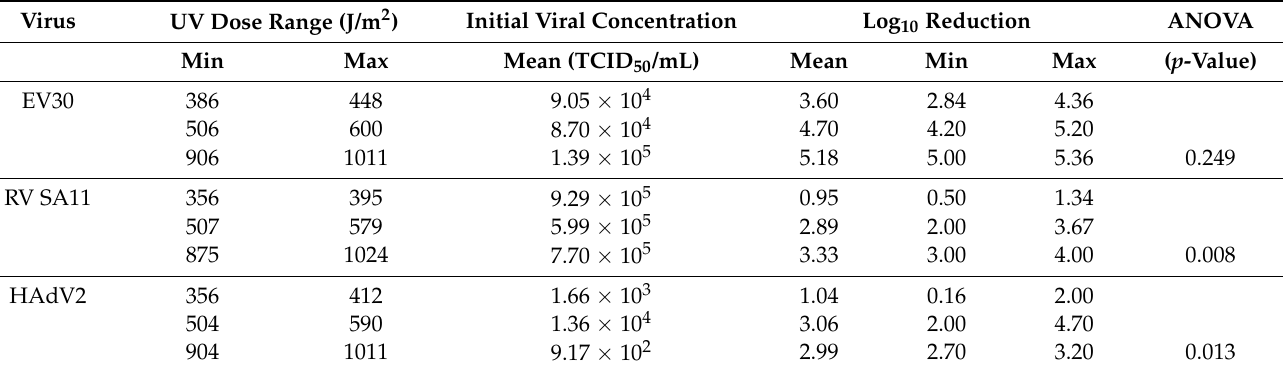
Table 2. Log 10 viral reduction of water suspension with EV30, RV-SA11, and HAdV2 after treatment with UV